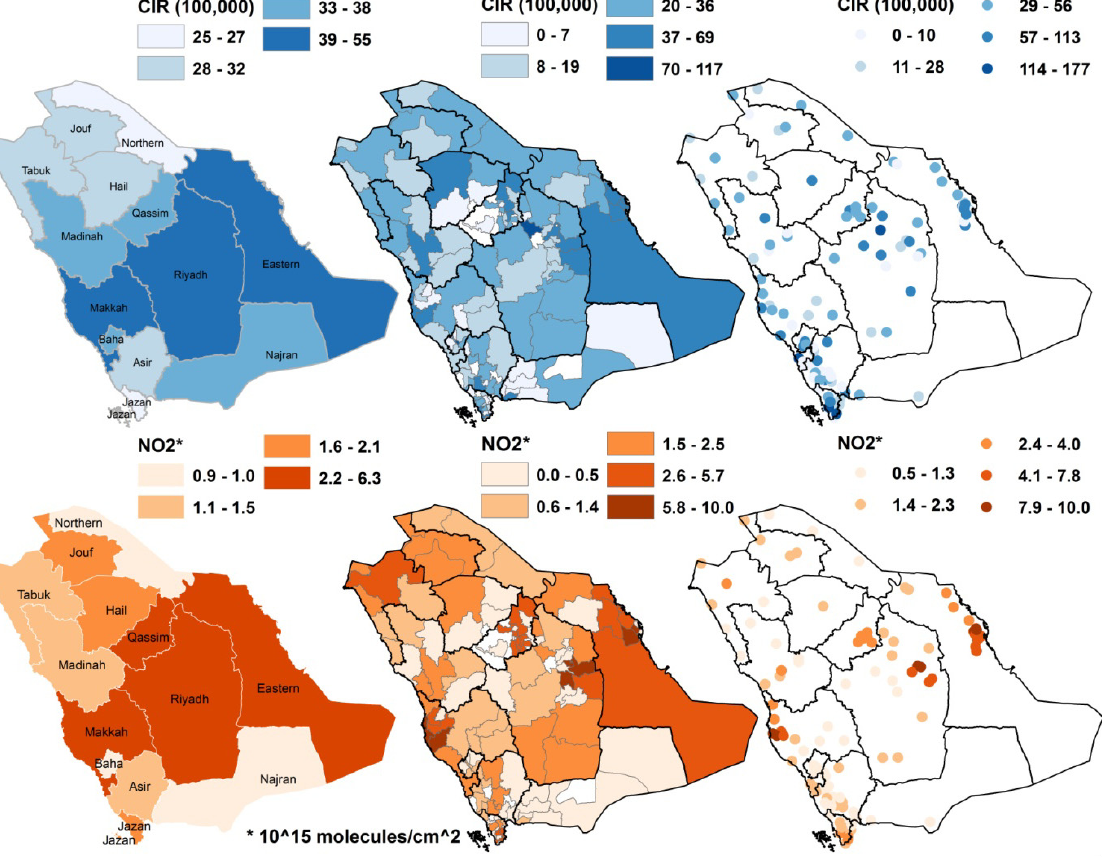
Table 2. Association between NO